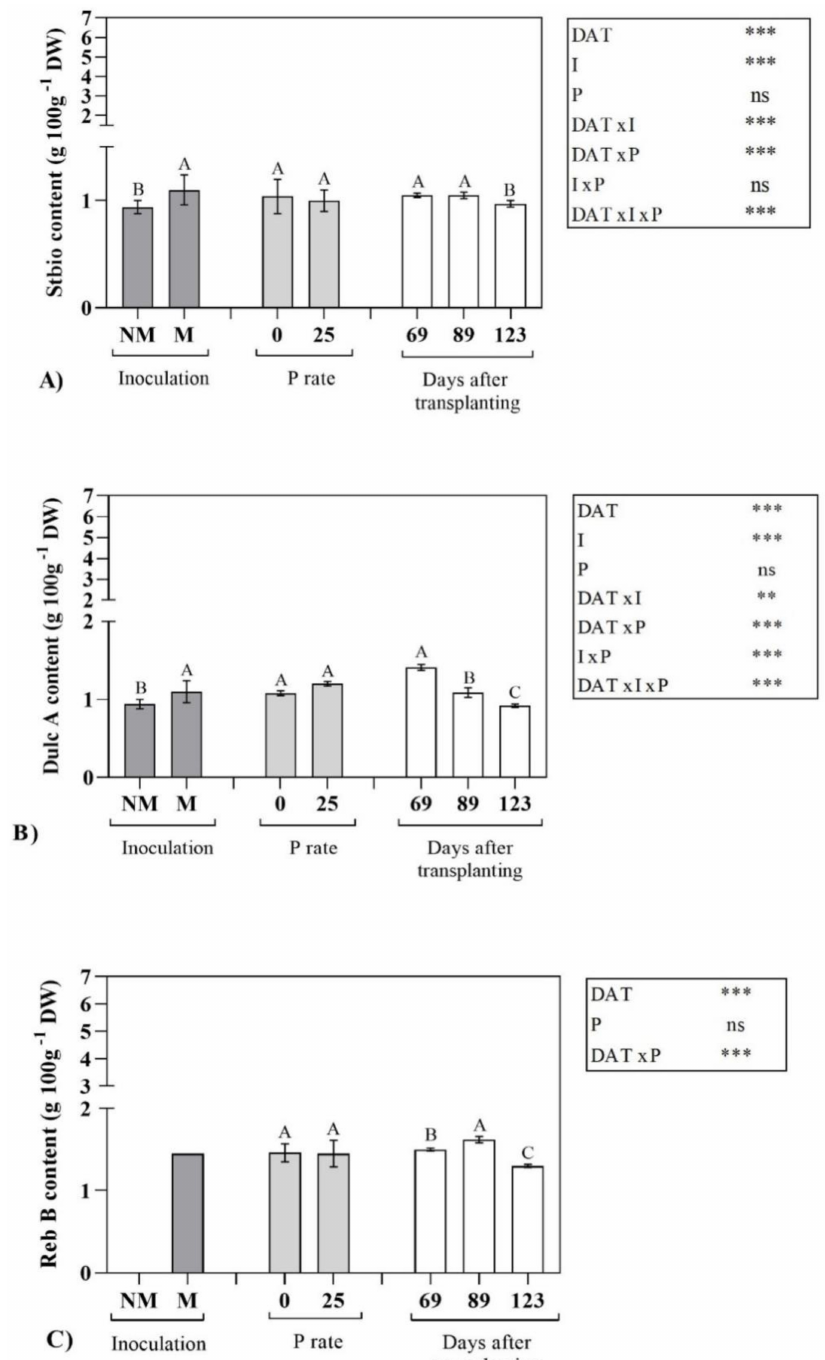
Figure 2. E ff ect of inoculation (I), P rate (P) and days after transplanting (DAT) on the content (g 100g − 1 DW) of Steviolbioside ( A ) and Dulcoside A ( B ) in Stevia rebaudiana Bert. leaf extracts. For Rebaudioside B ( C ), only the e ff ects of P rate and Days after transplanting have been shown. Means followed by the same letters are not significantly di ff erent at p < 0.05 according to L.S.D. Significance of variability factors (I, P and DAT) and their interaction are also reported, as follows: ns, not significant; **, significant at p ≤ 0.01; ***, significant at p ≤ 0.001 level. Stbio, steviolbioside; Dulc A, dulcoside A; Reb B, rebaudioside